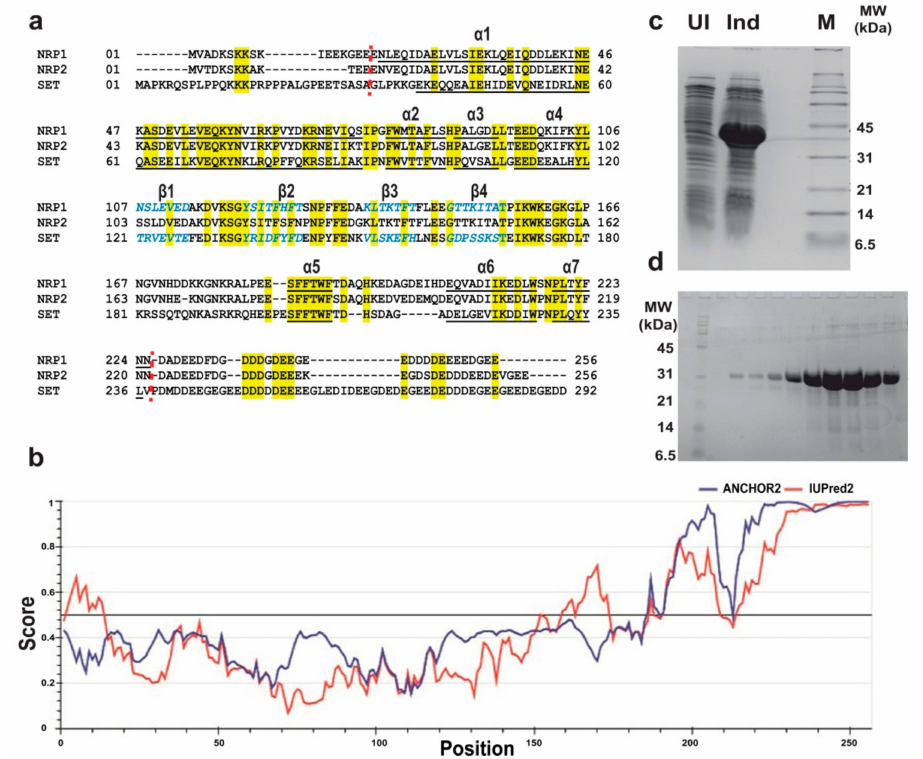
Figure 2. Expression, purification, and sequence analysis for AtNRP2. ( a ) Sequence alignment of AtNRP2 with AtNRP1 and HsSET / TAF-1 β . All the conserved residues are shown in yellow. Secondary structures of known structures are shown; wherein, α -helices are underlined, and β -sheets are in blue and italics. Red dotted lines mark the regions where AtNRP2 was truncated based on the secondary structure information of the other two proteins. ( b ) IUPRED prediction of disordered regions of AtNRP2. ( c ) SDS-PAGE imageshowing the expression of AtNRP2 NT / CT upon IPTG induction. The lanes are marked as UI = uninduced, Ind = Induced, and M = Marker. ( d ) SDS-PAGE image showing the purified peak fractions of AtNRP2 NT / CT from gel-filtration chromatography using HiLoad 16 / 600 Superdex 200pg column (GE Healthcare).The extreme left lane has the marker, and the remaining lanes have the fractions of the protein from